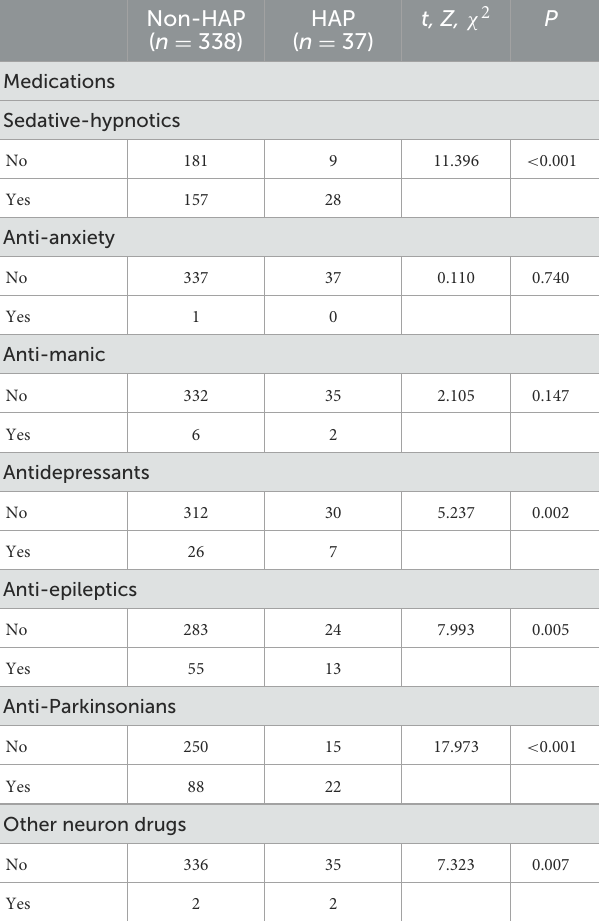
TABLE 3 Differences between HAP and non-HAP groups in male SCZ patients with